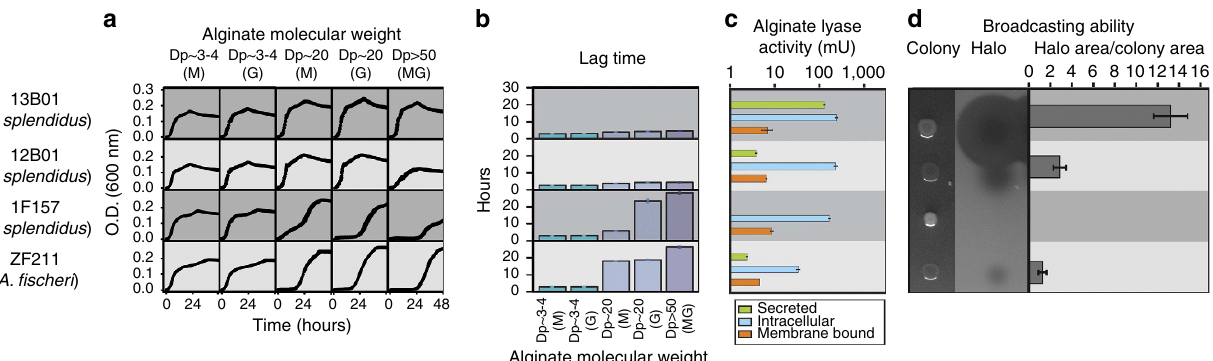
Figure 4 | Membrane-bound versus broadcasted alginate lyases dictate growth lag time. ( a ) Growth curves of isolates representing distinct pathway architectures on high- (degree of polymerization, Dp 4 50), medium- (Dp B 20), or low- (Dp B 3-4) molecular weight alginate. Low and medium molecular weight alginate was further purified into mannuronate (M)- or guluronate (G)- enriched fractions. ( b ) Quantified lag time differences between strains. ( c ) The cellular milieu was fractionated into extracellular (secreted), membrane-bound, and intracellular components. For each fraction, alginate lyase activity was measured using a bulk enzymatic activity assay (Methods). Among isolates assayed, those with longer lag phases displayed reduced broadcasted alginate lyase activity, despite similar levels of intracellular- and membrane-bound alginate lyase activity. Bar diagrams represent averaged technical replicates ( n ¼ 3). Error bars represent standard deviations of the mean. One unit of activity defines an increase of 1.0 in absorbance at 235nm per min. ( d ) Broadcasted alginate lyase activity measured independently with a plate-based assay (Methods). The size of the halo indicates the degree of broadcasted alginate lyase activity after a fixed period of time. Bar diagrams represent means of technical replicates ( n ¼ 5) and error bars represent s.d.